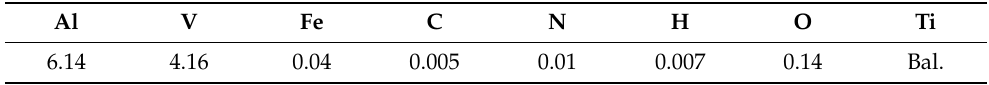
Table 2. Chemical composition of Ti6Al4V alloy employed in this study (wt.%). Al